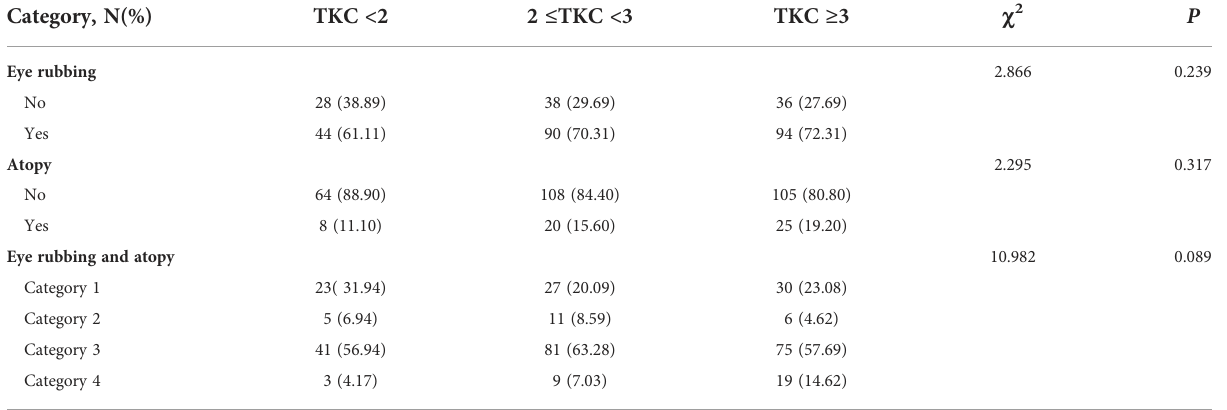
TABLE 4 Association between eye rubbing, atopy and KC